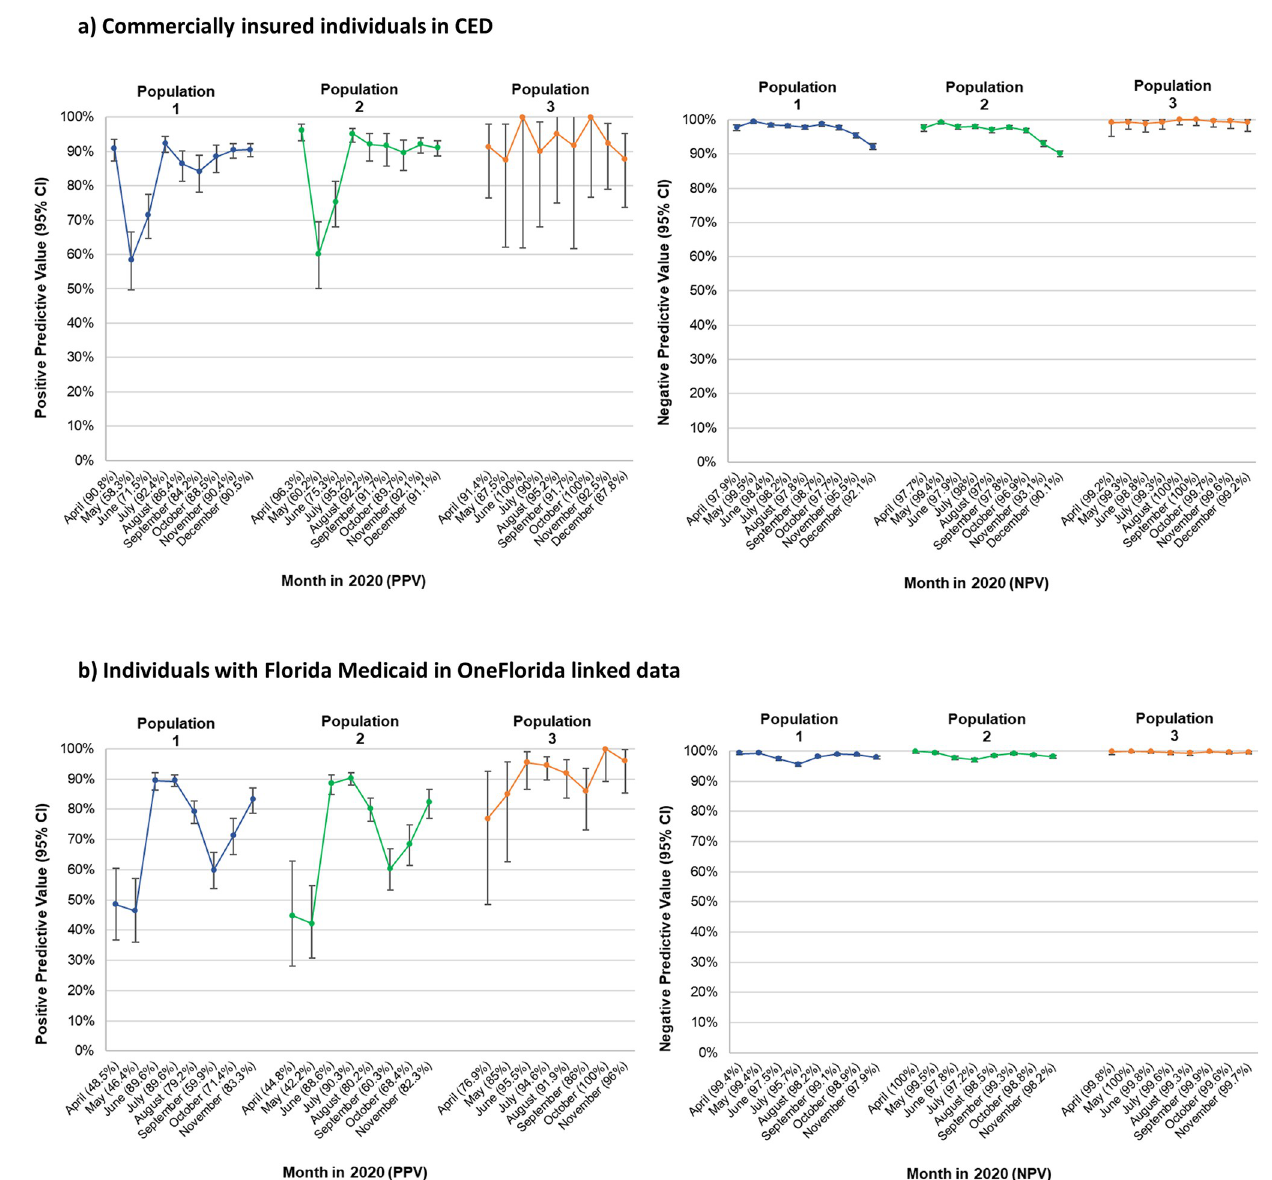
Fig 6. Monthly trends in performance characteristics (PPV/NPV) of diagnosis code U07.1 in claims data by population. Month corresponds to the month of the index event. Population 1: Diagnosis of COVID-19, symptoms, or potential exposure. Population 2: Severe acute respiratory